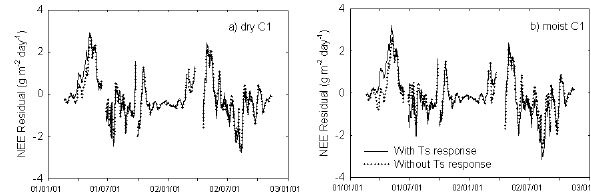
Fig. 6. Mean values of NEE residuals during 2001–2002 under dry and moist soil conditions, respectively, constrained by criteria C1. The solid line represents the mean NEE residuals based on DryTs or MoistTs, accounting for the effect of soil temperature responses on photosynthesis and transpiration. The dotted line represents the mean NEE residuals based on DryNoTs or MoistNoTs, without ac- counting for the effect of soil temperature responses on photosyn- thesis and transpiration. All values are 5-day